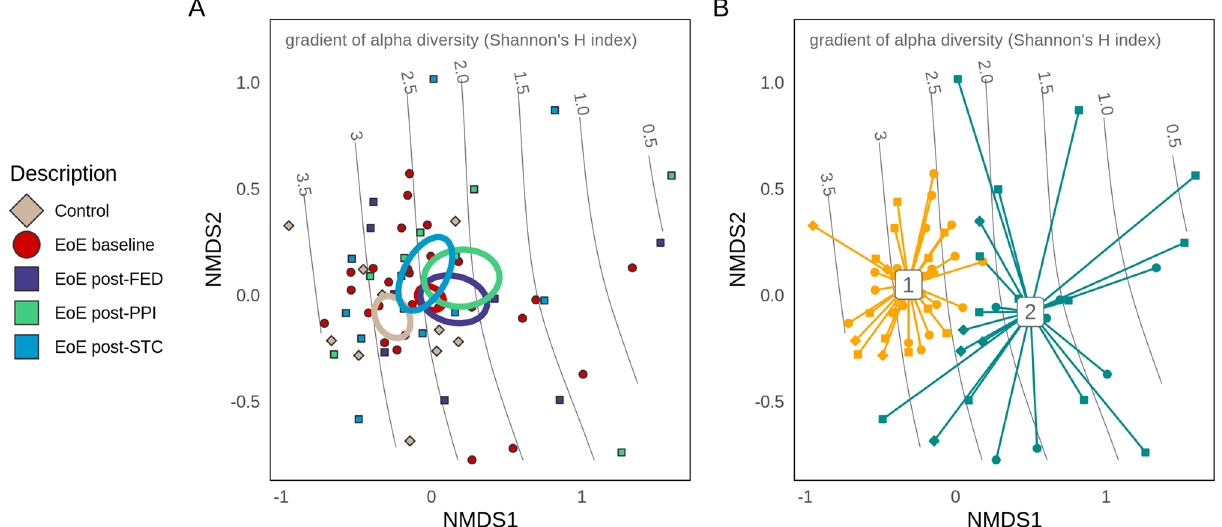
Figure 2. Comparison of microbiome beta-diversity across conditions based on ASV features using non-metric dimensional scaling (NMDS). Ellipses representing centroid position for each group, showing the distribution of samples and groups along the primary axis (NMDS1), closely aligned with a gradient in microbial alpha- diversity ( A ); Dirichlet multinomial mixture (DMM) groups defined through differences in patterns of abundance were well separated along the primary X axis and gradient in alpha-diversity ( B